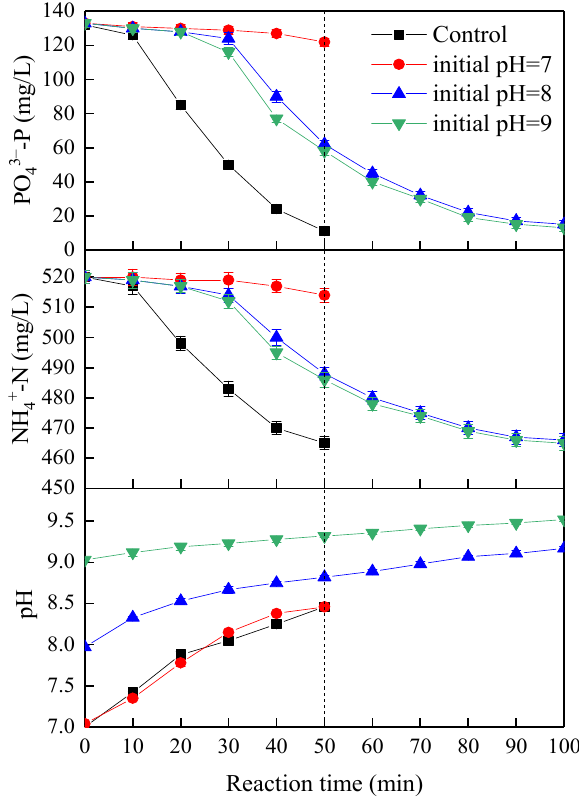
Figure 12. Feasibility tests for mitigating the effect of high concentration organic substances by adjusting initial pH at a current density of 4 mA/cm 2 .